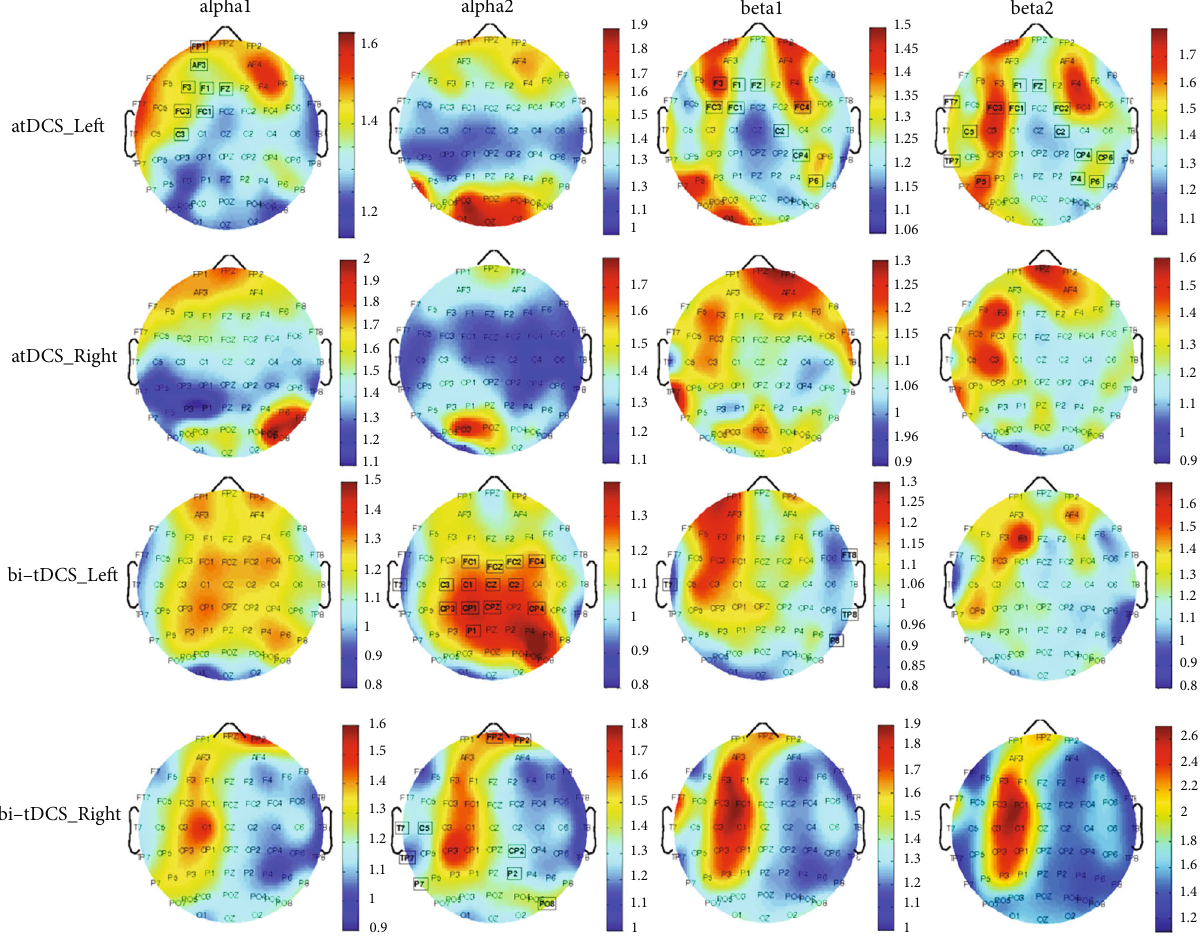
Figure 1: Cortical activity change of alpha (alpha1 (8-10Hz) and alpha2 (10-13 Hz)) and beta (beta1 (13-20Hz) and beta2 (20-30Hz)) bands induced by anodal transcranial direct current stimulation (atDCS) and bilateral transcranial direct current stimulation (bi-tDCS) in stroke subjects with the left hemispheric lesion and right hemispheric lesion. Color of the brain topographic map represents the spectral power ratio of post- to prestimulation. The bordered labels represent regions in which spectral power was signi fi cantly di ff erent between post- and prestimulation ( p < 0 : 05